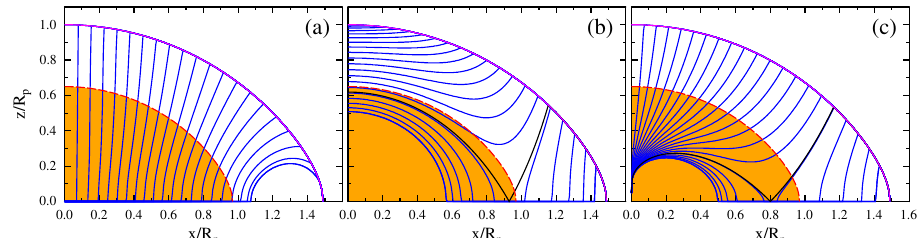
Figure 25. Curves of internal constant angular velocity Ω ( r , θ )= const in the stellar envelope (blue lines). ( a ) Curves corresponding to the condition S = S ( j 2 ) ; ( b ) curves obtained with S = S ( Ω 2 ) ; and ( c ) curves calculated for S = S ( (cid:118) 2 Ω 2 ) . The solutions are valid in the convective envelope, i.e., above the shaded central region [ S = specific entropy; j = specific angular momentum; and (cid:118) = distance to the rotation axis]. Ordinates coincide with the rotation axis; abscissas are in the equatorial plane. Adapted from Zorec et al. [141].